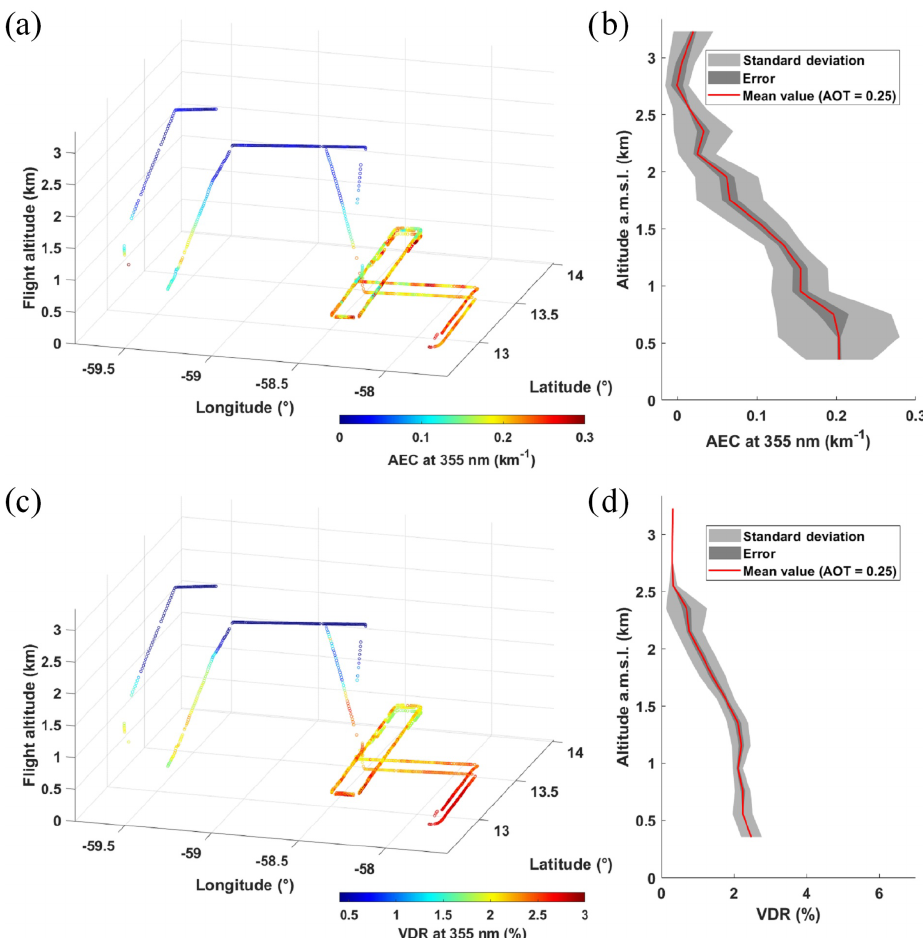
Figure 2. Same as Fig. 1 during flight F08 on 31 January 2020 at 19:45–24:00UTC.